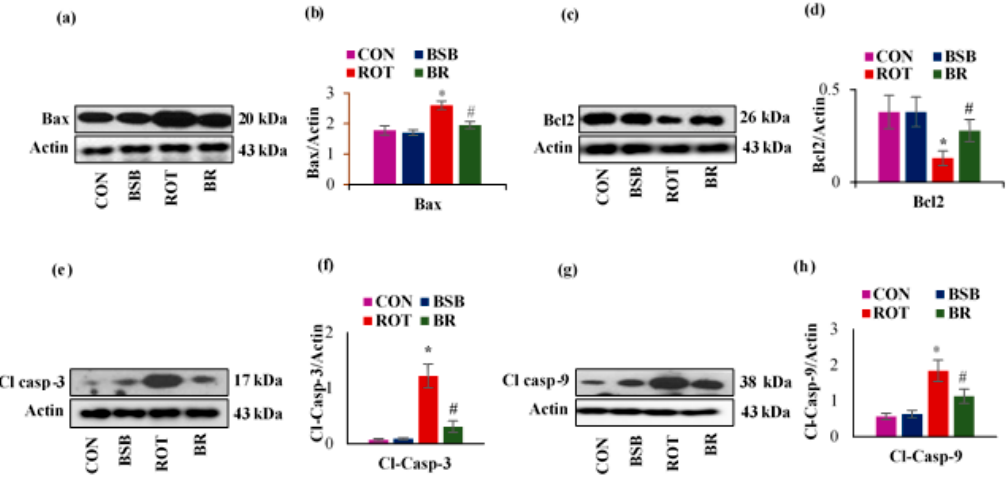
Figure 8. The protein expression of anti-apoptotic marker Bcl-2 and proapoptotic markers such as Bax, cleaved caspase-3 and 9 was estimated in the striatal tissues ( a – h ). The quantification of the blots showed that significant decrease in Bcl-2 expression ( c , d ) and significant increase in Bax ( a , b ), cleaved caspase-3 ( e , f ) and cleaved caspase-9 expression ( g , h ) in the ROT injected rats when compared to control (CON) rats. Whereas, BSB treatment significantly corrected the expression of these antiapoptotic and proapoptotic proteins in the rats, which were challenged with, ROT. Moreover, BSB alone treatment to rats had no marked e ff ects on the expression levels of these apoptotic markers. Values are expressed as the mean ± SEM (n = 3). * p < 0.05 CON vs. ROT; # p < 0.05 ROT vs. BR (One-way ANOVA followed by DMRT).